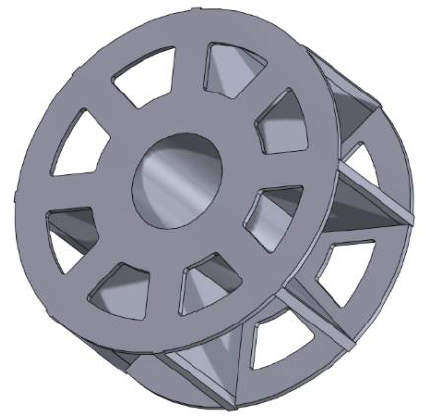
Figure 9. 3D model of the rotor mechanism.